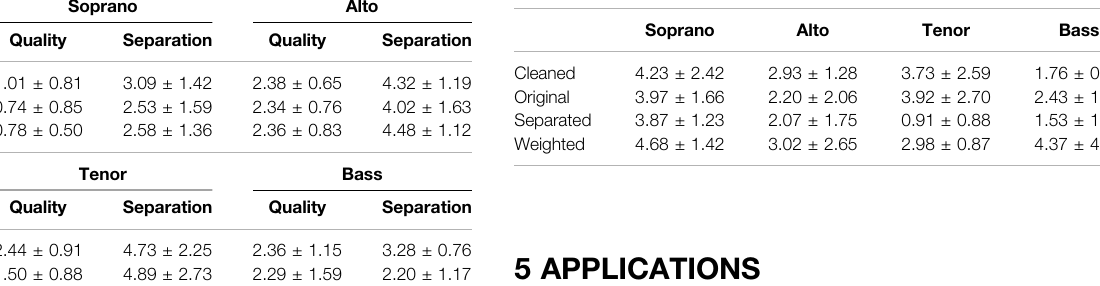
TABLE 9 | Normalized MOS results of the subjective listening tests pertaining to thecleaningoftheECDdatasetandtheadherancetothemelodyoftheunison